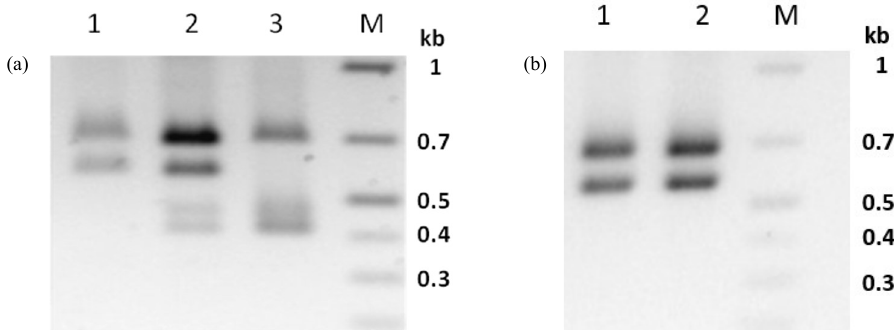
Figure 4. Agarose gel (1%) electrophoresis of the AluI digested PCR product egt of PhopGV-CR3 ( a ) DNA from PhopGV-CR3 occlusion bodies, egt type III (1), DNA extracted from CR3 infected Phop-IT single larva (CR3.1), mixture of egt type II and III (2) and DNA extracted from PhopGV-R infected single larva, egt type II (3). AluI digested PCR product egt of PhopGV-GR1 ( b ) DNA from PhopGV-GR1 occlusion bodies, egt type III (1) and DNA extracted from PhopGV-GR1 infected Phop-IT single larva (PhopGV-GR1.1), egt type III (2). M = GeneRuler 1 kb plus DNA ladder (Thermo Scientific). A negative image of the stained gel is shown for better visualization of the PCR fragments.